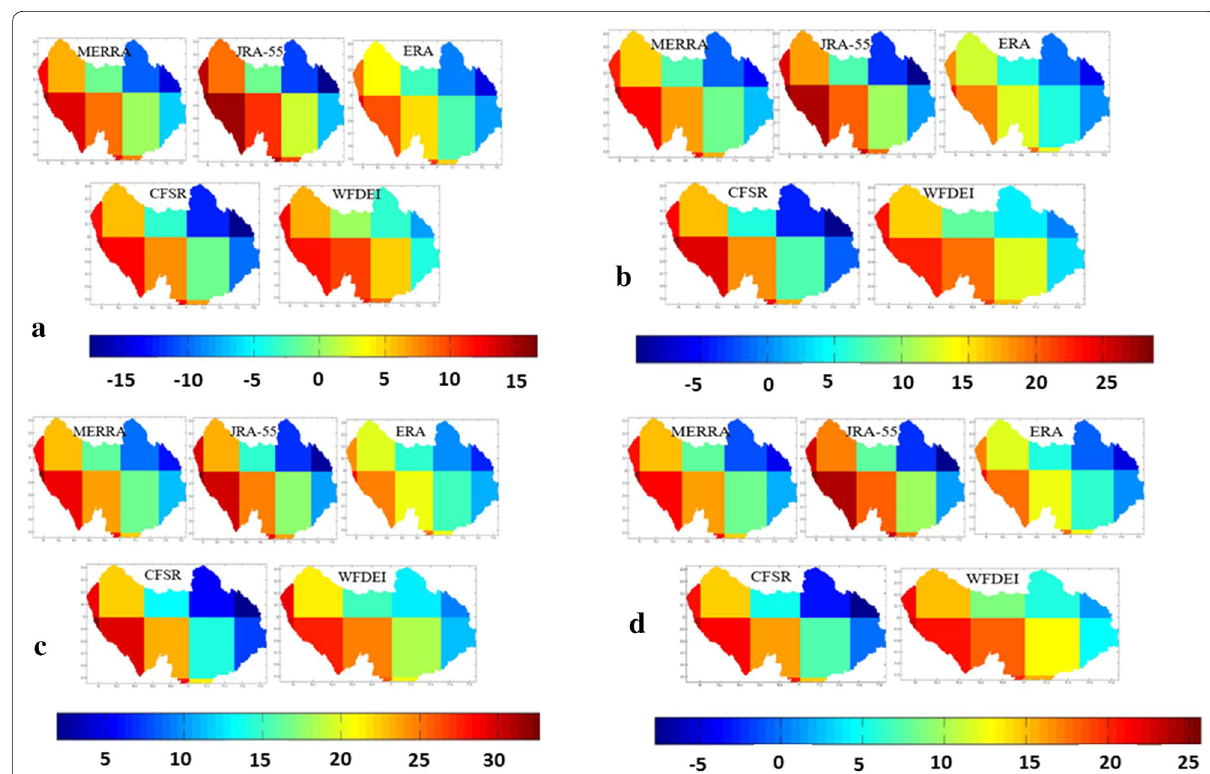
Fig. 3 Spatial variation of gridded temperature during ( a ) Winter (December-February), ( b ) Summer (March–May), ( c ) Monsoon (June–August) and ( d ) post-Monsoon (September–November)